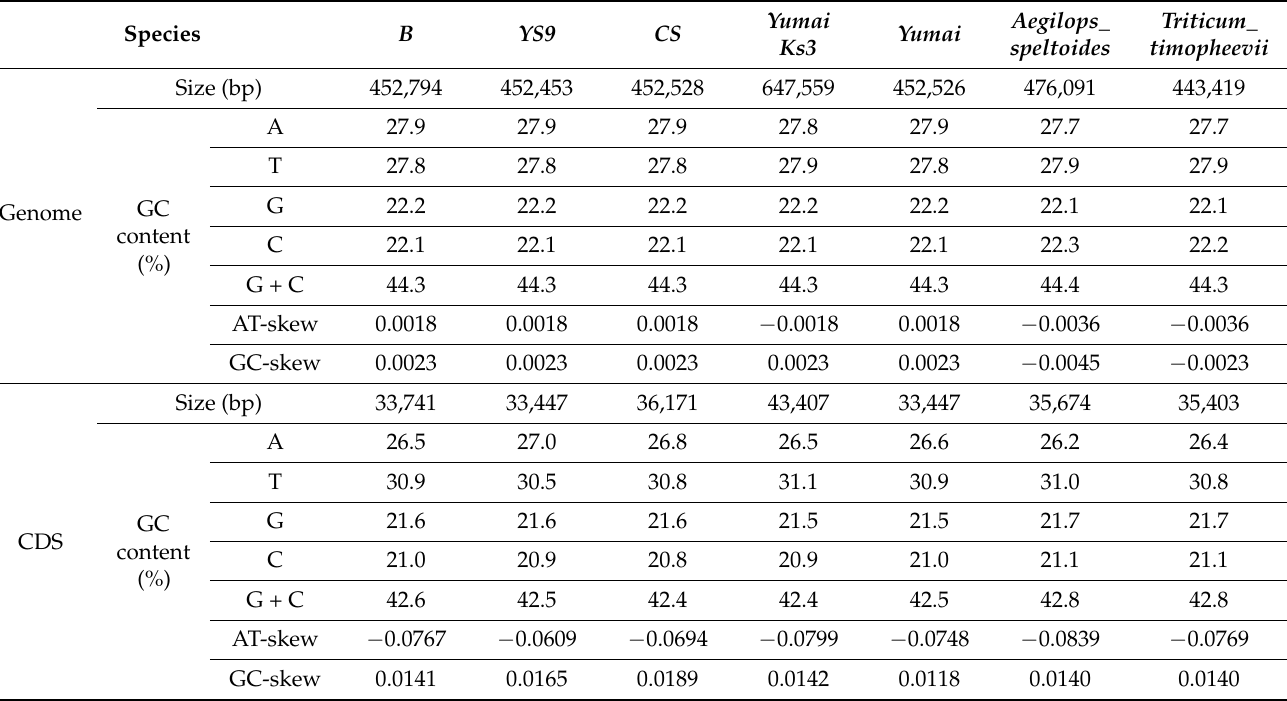
Table 1. Genomic features of B and YS9 mitogenome.